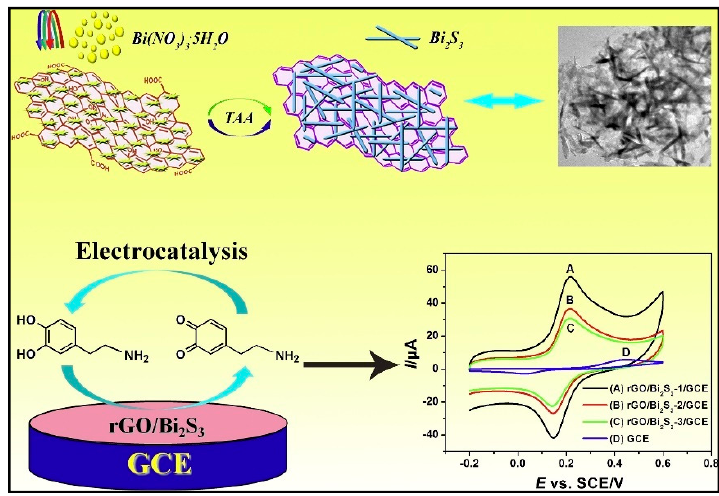
Figure 1. The schematic illustration of in-situ synthetic route of rGO/Bi 2 S 3 composites and the electrocatalysis of DA at rGO/Bi 2 S 3 /GCE. Reprinted from [70] with permission of Elsevier.